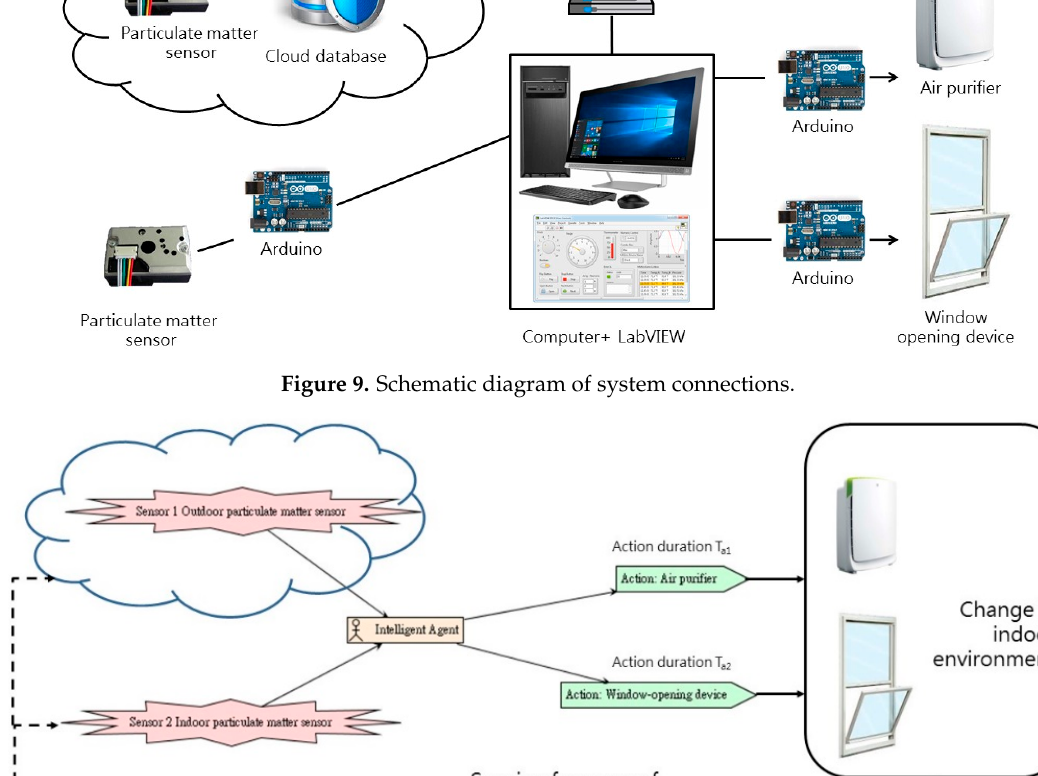
Figure 10. Individual intelligent agent module.